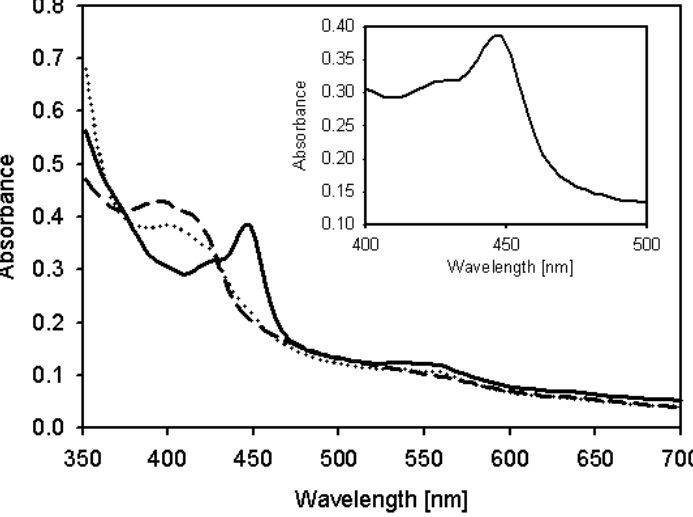
Figure 3. UV-visible absorbance spectra of expressed CYP105D7. Dashed line: oxidized CYP105D7, Dotted line: Reduced form with dithionite, Solid line: CO-bound form spectra with dithionite. The insert represents the CO difference spectra.